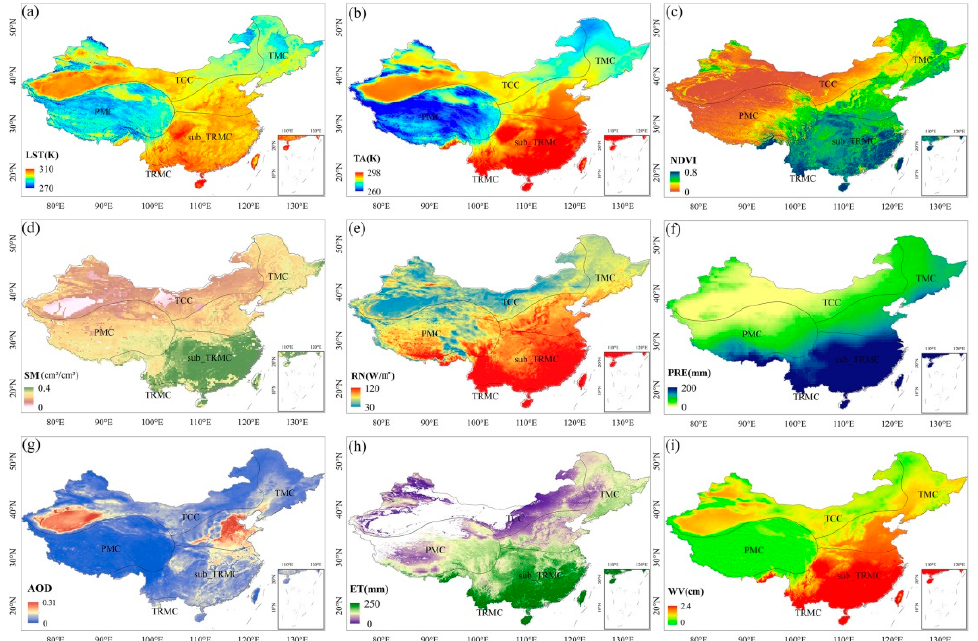
Figure 2. Spatial distribution of the multi-year mean of LST and eight environmental factors in China from 2003 to 2018. ( a ) LST ( b ) TA ( c ) NDVI ( d ) SM ( e ) RN ( f ) PRE ( g ) AOD ( h ) ET ( i ) WV. The geographical locations include temperate continental climate region (TCC), temperate monsoon climate region (TMC), plateau mountain climate region (PMC), subtropical monsoon climate region (sub_TRMC), and tropical monsoon climate region (TRMC).